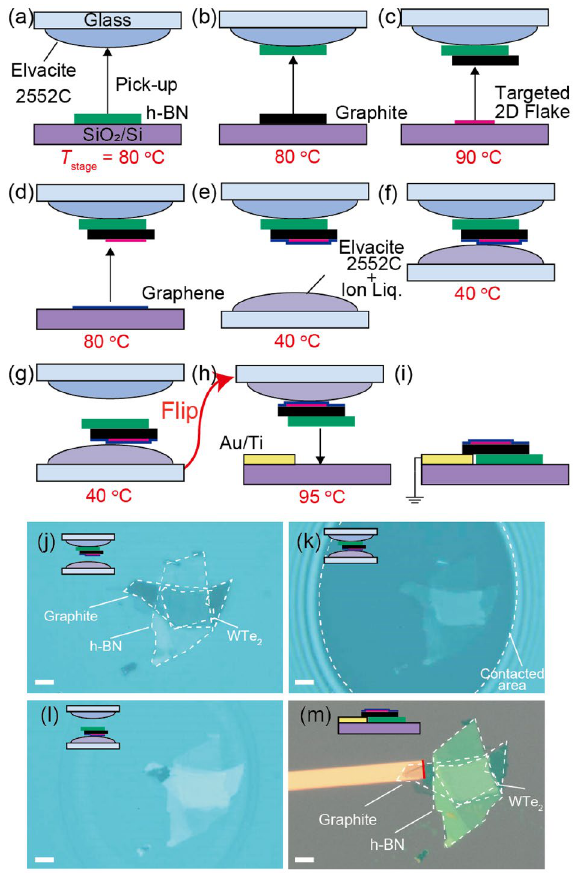
Figure 3. Schematics of dry pick-and-flip assembly process of 2D crystals for ARPES. First, ( a ) thick h-BN, ( b ) thick graphite, ( c ) targeted 2D crystals, and ( d ) graphene are picked-up by Elvacite2552C at T stage of ( a ) 80 , ( b ) 80 , ( c ) 90 , and ( d ) 80 ◦ C inside the glovebox. ( e – g ) Heterostructure on Elvacite2552C is released onto ◦ C a second Elvacite2552C-IL compound with an IL content of 39.4 wt% at T stage = 40 . The adhesive force of Elvacite2552C to the heterostructure is weaker than to that of Elvacite2552C-IL compound; the heterostructure transfers to the second stamp. ( g ) and ( h ) Heterostructure is flipped and released onto a SiO 2 /Si substrate with ◦ C prepatterned metal electrode in the ambient condition at T = 95 . ( j – m ) Optical microscopic images of the heterostructure corresponding to ( e – i ). The scale bars correspond to 10 µ m